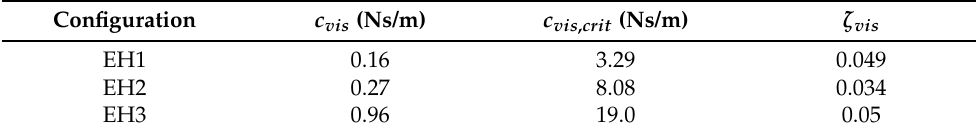
Figure 6. Exponential decay of viscous damping for EH1. Table 5. Viscous damping values of the energy